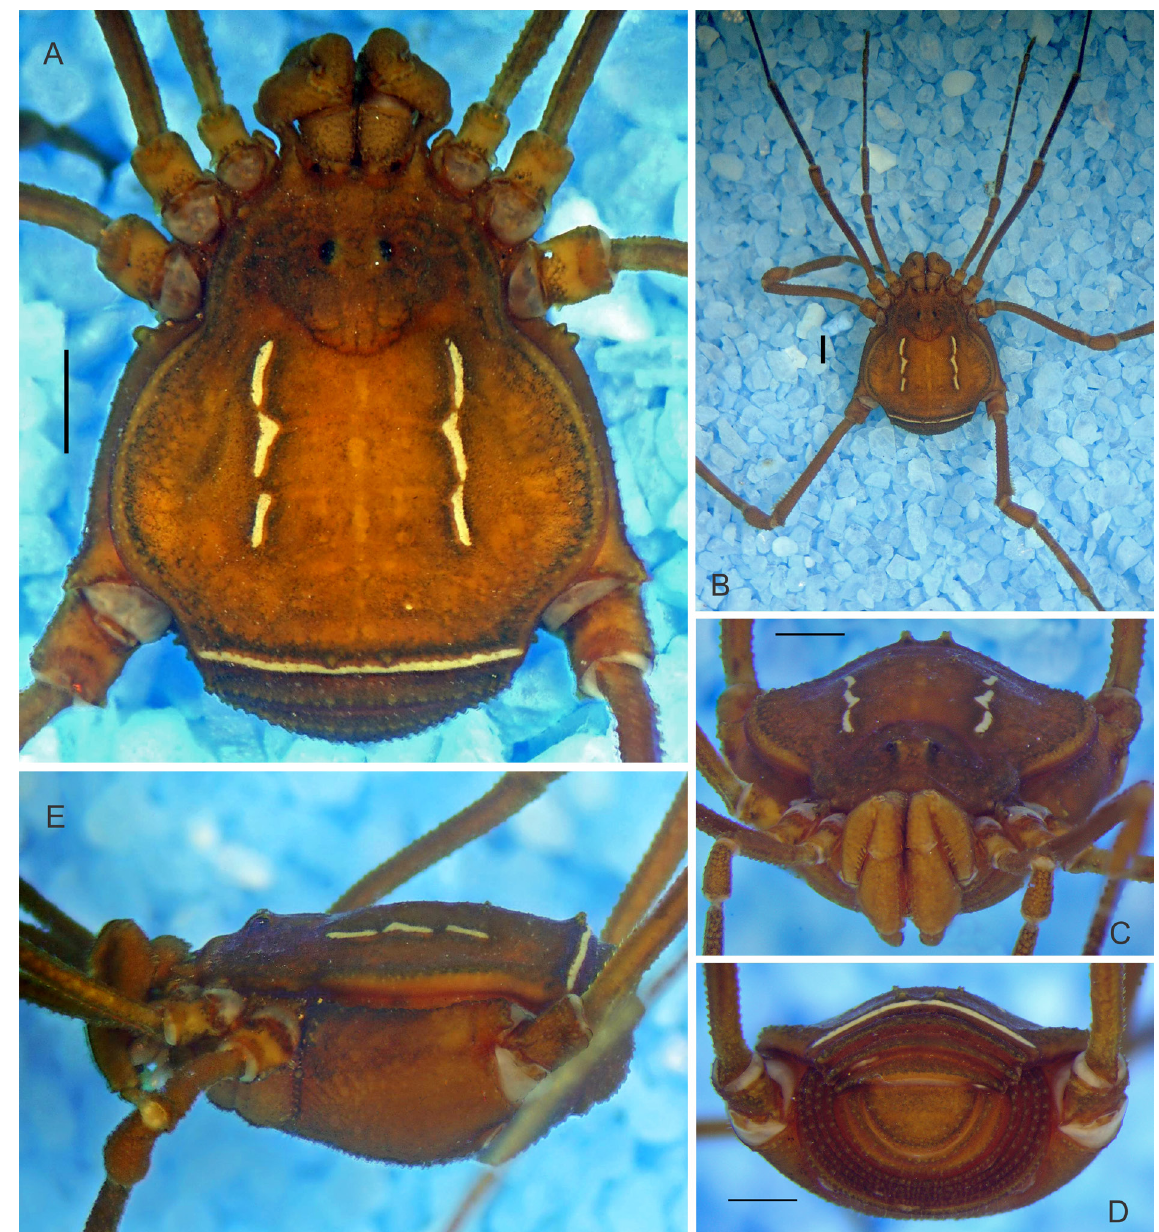
Fig. 15. Eulibitia leda sp. nov., ♂, holotype (ICN-AO 1165), habitus. A . Dorsal view. B . Panoramic, dorsal view. C . Frontal view. D . Posterior view. E . Lateral view. Scale bars: 1